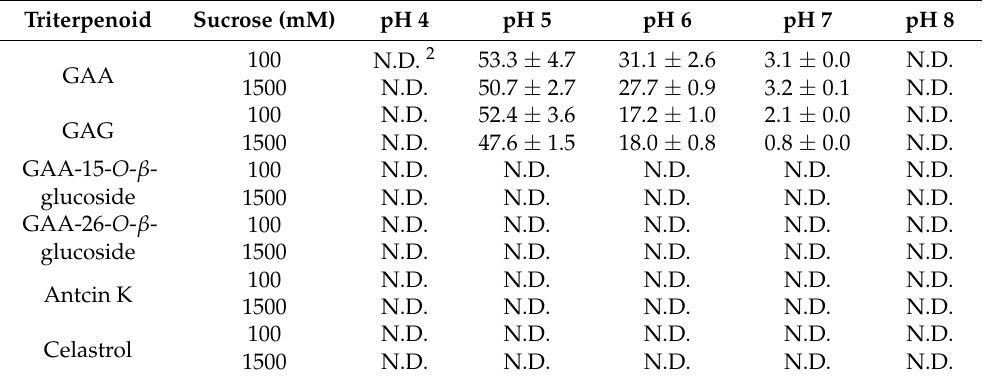
Table 1. Glycosylation activity 1 of Dg AS toward tested triterpenoids at different pH and sucrose concentrations.